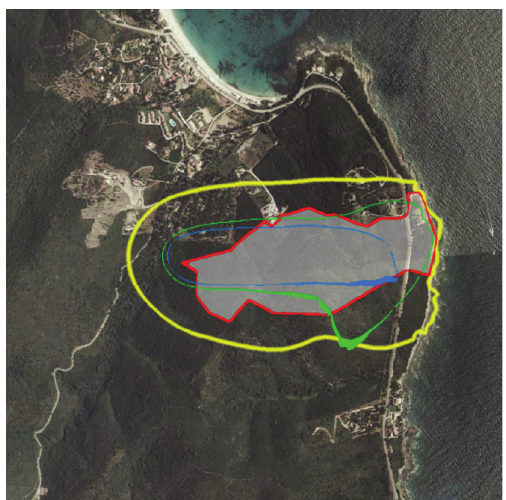
Figure 14: Case 2: Simulations results and observations for the Favone fire. Blue: simulated fire contour at 15:50 (after 50 (cid:4)(cid:4) ), Green: simulated contour at 19:00, yellow: simulated contour at 19:00 (non coupled); Red: final observed contour of the